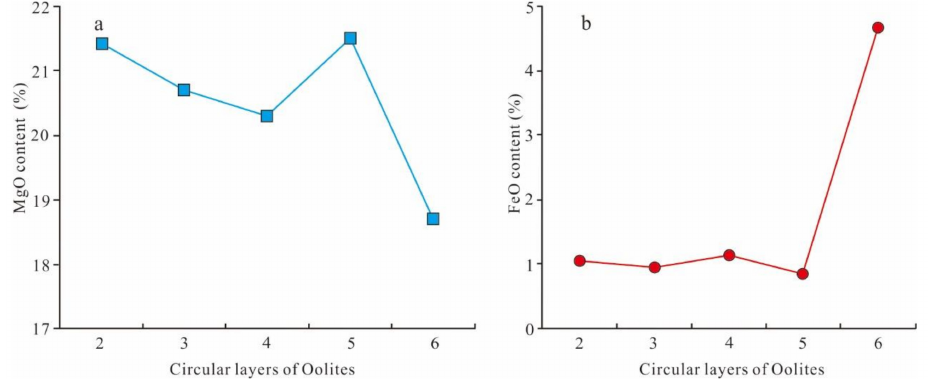
Figure 6. MgO and FeO contents in different circular layers of